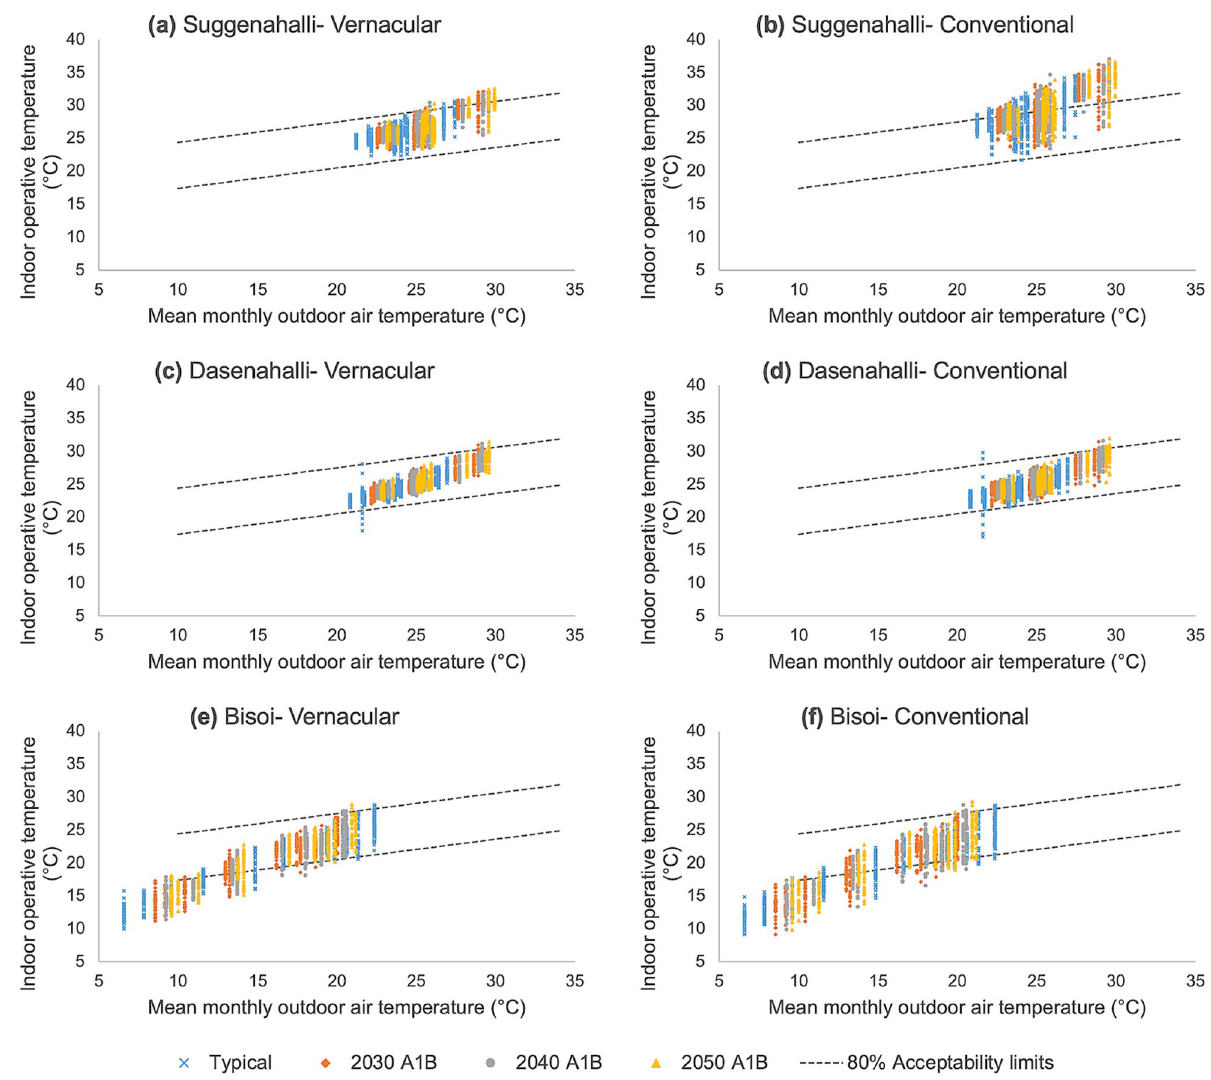
Figure 8. Indoor operative temperature against mean monthly outdoor air temperature for vernacular and conventional dwellings in the three settlements in typical and future climate for A1B scenario: Each plot shows the daily indoor operative temperatures (in °C) inside the dwelling throughout a year plotted against mean outdoor air temperature (in °C) for the corresponding month. The two dotted lines shown in each figure indicates the 80% acceptability limits prescribed by ASHRAE 55 Adaptive thermal comfort model. The points lying within the 80% acceptability limit band are considered to be comfortable by at least 80% of the inhabitants, while those lying outside indicate thermal discomfort. Higher number of points lying outside the band indicate higher discomfort in the given dwelling. Comparing ( a ) and ( b ), conventional dwelling tends to be highly uncomfortable throughout the year for typical as well as future scenarios. Comparing ( c ) and ( d ), there is only marginal difference between vernacular and conventional dwelling in Dasenahalli. Comparing ( e ) and ( f ), though both vernacular and conventional dwelling tend to be uncomfortable at lower outdoor temperatures, vernacular dwelling seems to be warmer than conventional dwelling providing better comfort in cold